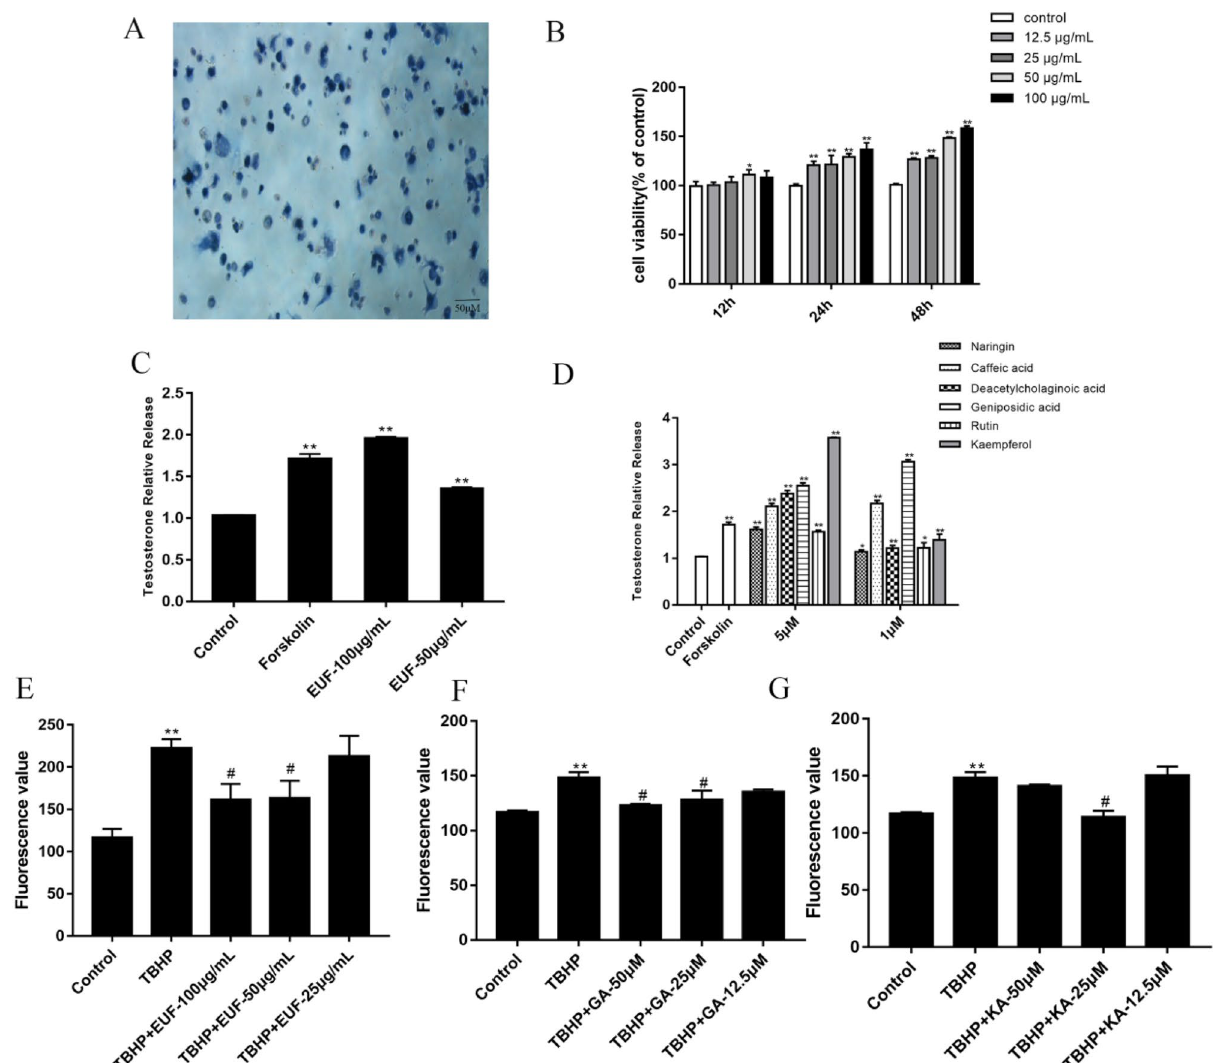
Figure 1. Effect of EUF on testosterone secretion in Leydig cells. ( A ) 3β-HSD staining of Leydig cells (200 ×). ( B ) Effect of EUF extract on the viability of Leydig cells. ( C ) Effect of EUF extract on the testosterone content. ( D ) Effect of monomer on the testosterone content. ( E – G ) EUF extract, geniposidic acid and kaempferol decreased TBHP-induced intracellular ROS levels. versus the controls: ** P < 0.01, * P < 0.05; versus the TBHP group: ## p < 0.01, # p < 0.05. KA, kaempferol; GA, geniposidic